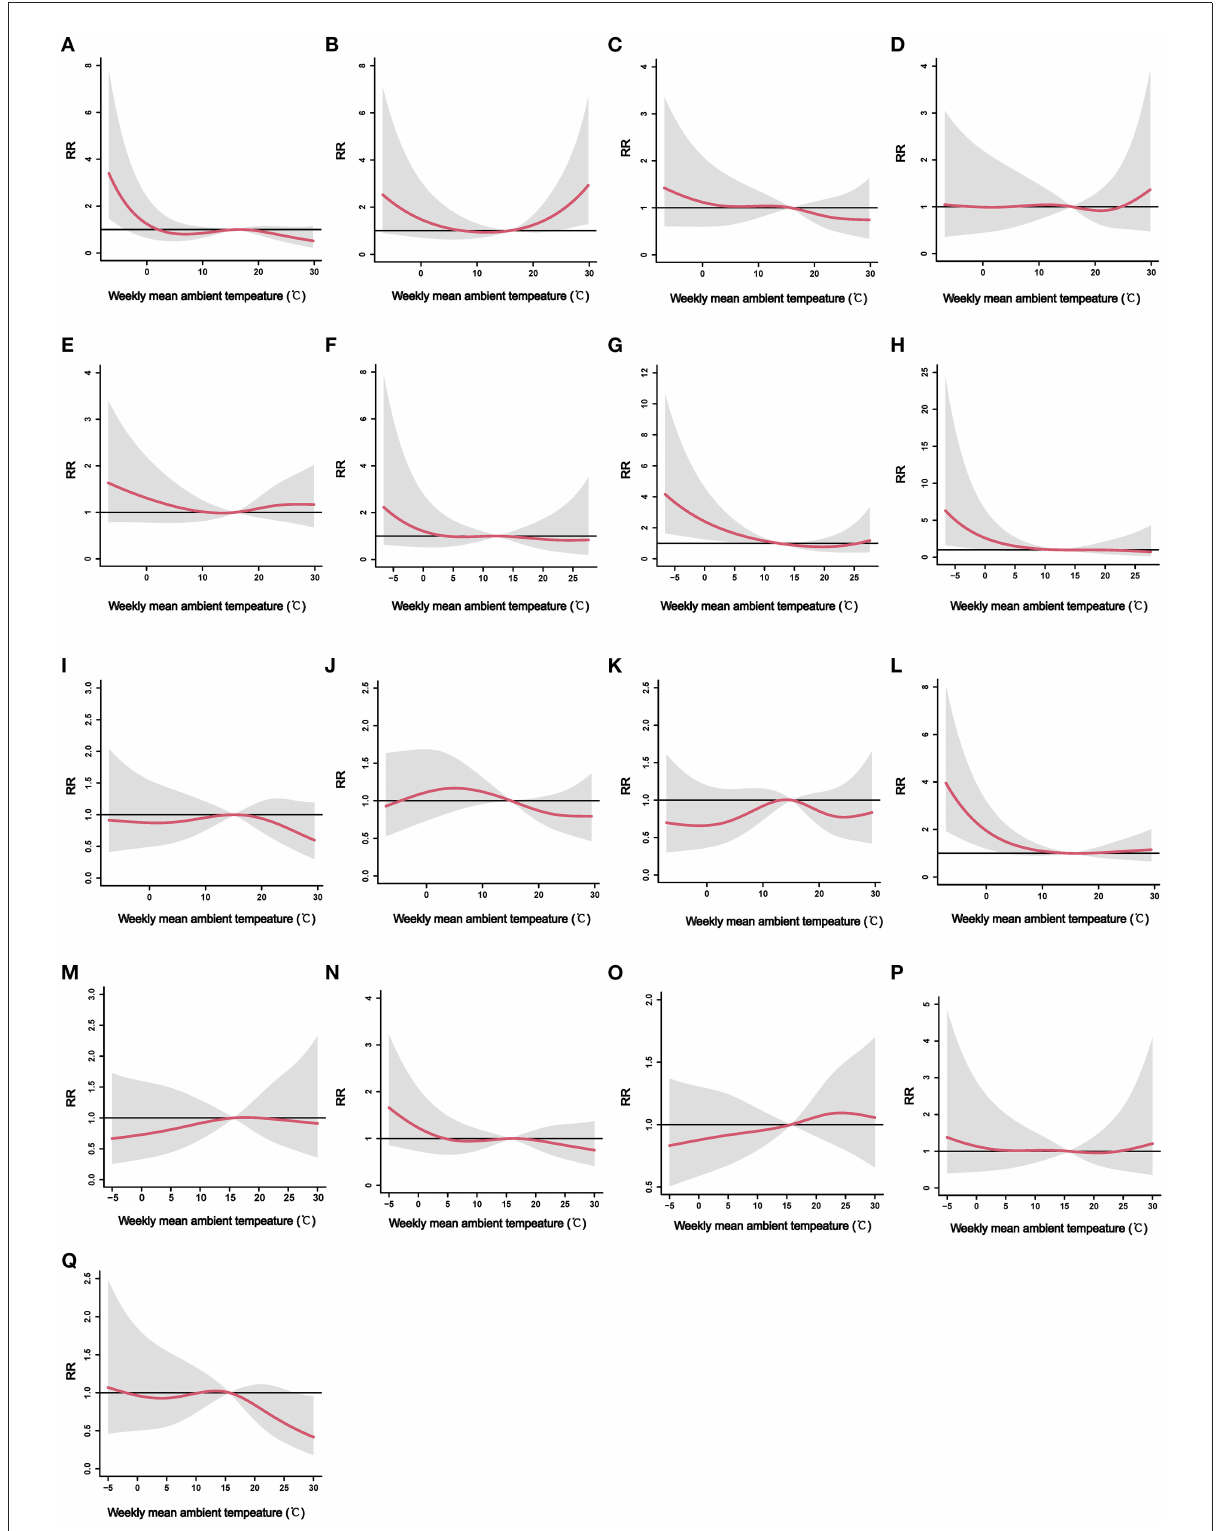
FIGURE2 The city-specific exposure–response curves of the cumulative effects of weekly mean ambient temperature on ILI. ILI, influenza-like-illness; RR, relative risk. (A) Jinan, (B) Taian, (C) Laiwu, (D) Zibo, (E) Weifang, (F) Qingdao, (G) Yantai, (H) Weihai, (I) Liaocheng, (J) Dezhou, (K) Binzhou, (L) Dongying, (M) Jining, (N) Zaozhuang, (O) Linyi, (P) Rizhao, and (Q)